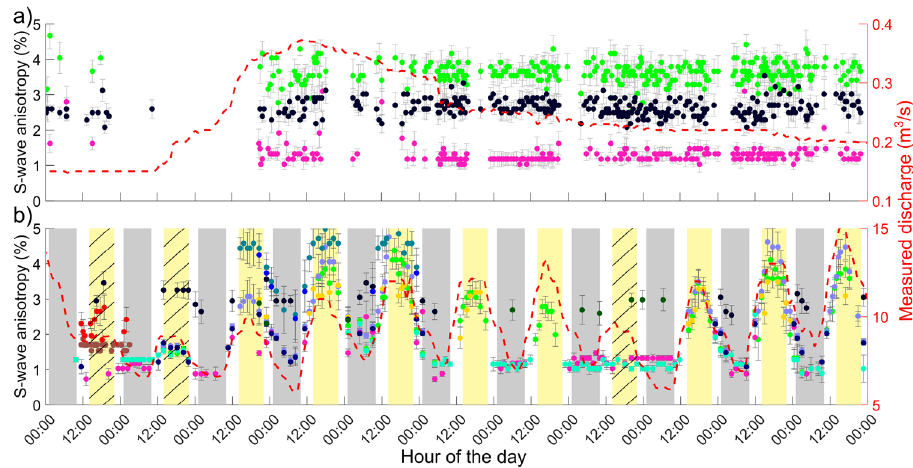
Fig. 3 Time series of the magnitude of englacial S-wave anisotropy within Rhonegletscher during winter and summer. a , b 11-day long time series of shear wave anisotropy magnitude with 95% con fi dence interval (coloured dots with grey uncertainty bars, respectively) and meltwater discharge (red dashed line) measured during winter ( a ) and summer ( b ). a 11-day long time series starting on 10 March 2018. b Time series starting on 21 July 2018. Colours of dots represent different icequake cluster-seismometer pairs. Time windows used in the low and high anisotropy scenarios for ice-fabric inversions are shaded with grey and yellow, respectively. Hatched time windows indicate high anisotropy time windows with meltwater discharge not exceeding 10 m 3 s − 1